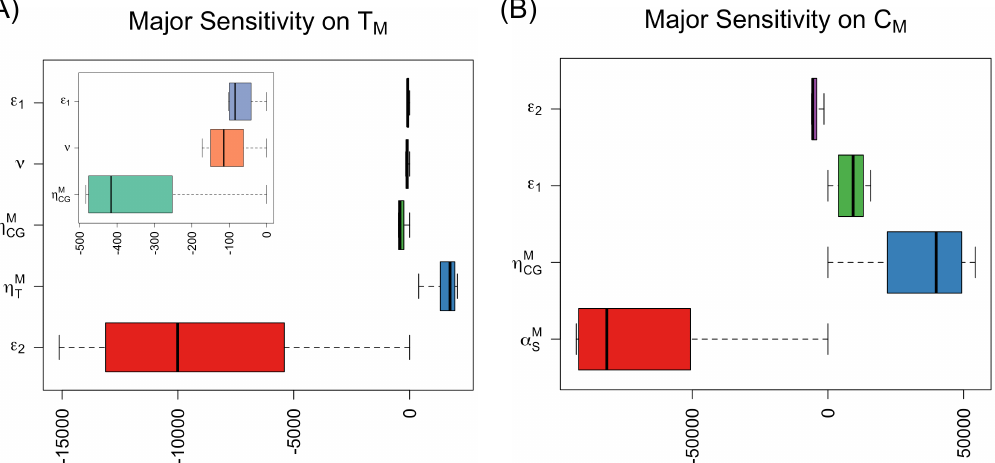
Figure 4. Sensitivity of significant parameters on thalassemia and carrier population ( T M and C M ). ( A ) Sensitivity of ε 1 , ν , η M , η M and ε 2 on thalassemia population ( T M ) (the little box is the enlarged T CG plot of ε 1 , ν , η M , for eyes). ( B ) Sensitivity of ε 2 , ε 1 , η M , η M and α S on carrier population ( C M ). See T M CG CG parameter names shown in Table